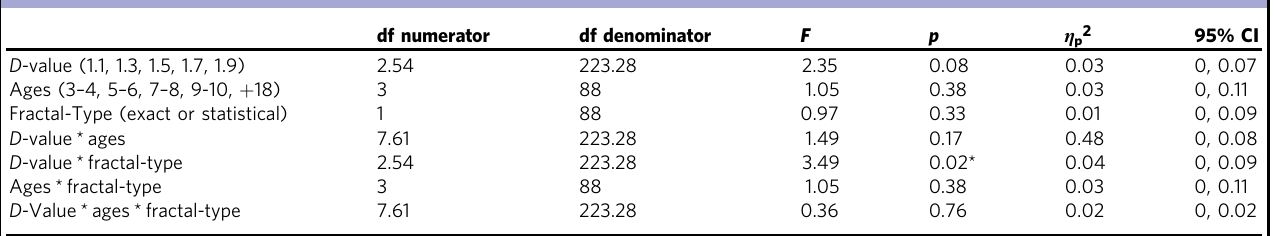
Table 2 Mixed ANOVA across D- value, ages, and fractal type. df numerator df